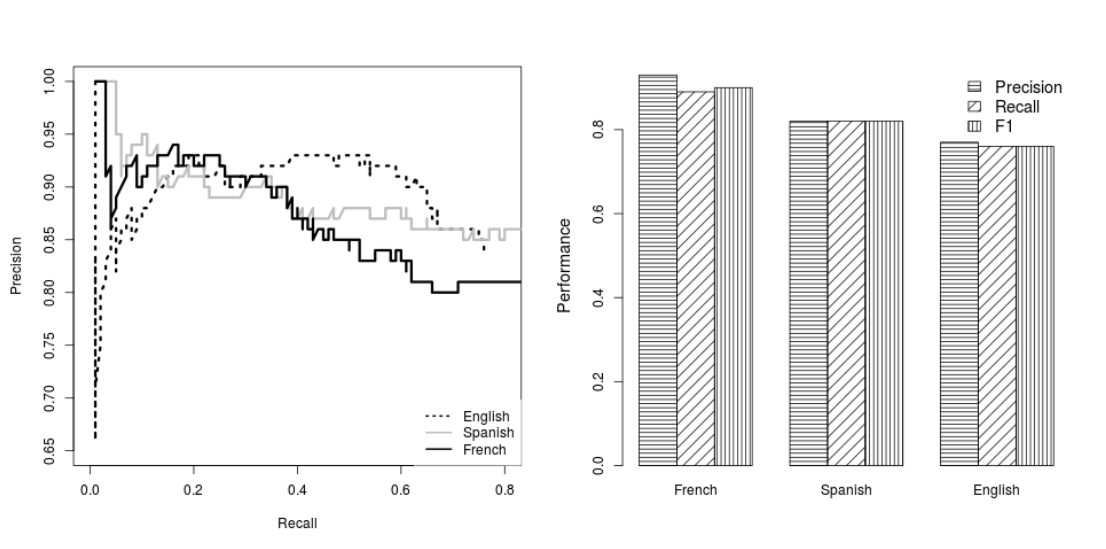
Figure 3: Precision and recall plot of the pruning algorithm across languages using Dataset 1